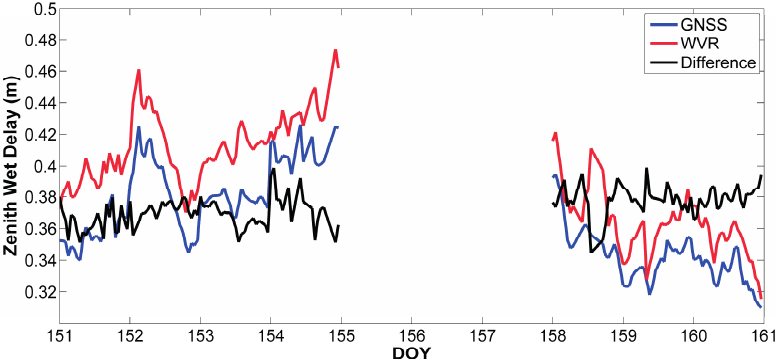
Figure 7. Comparison of wet troposphere delays derived from GNSS and WVR in Yuanchang. The time span is from 30 May 2008 to June 8, 2008 (day of year (DOY): 151–160). Differences of GNSS- and WVR-derived wet troposphere delays (black curve) shift a constant value of 40 cm.